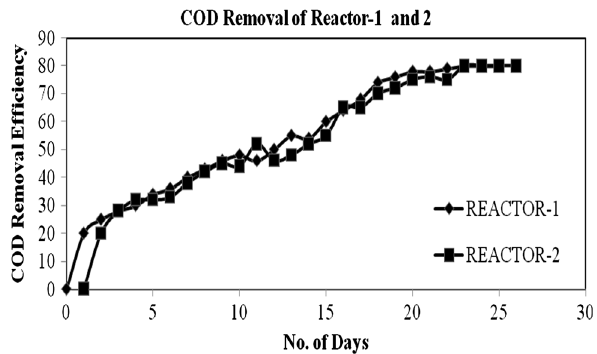
Fig. 2 COD removal efficiencies of aerobic set of reactors during the start-up phase